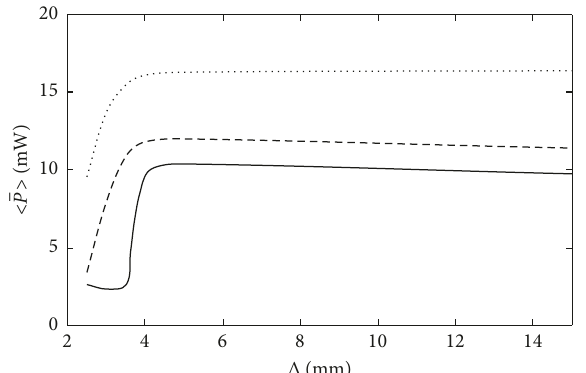
Figure 8: The effective output power generated on the electric load ( R ) as a function of parameter Δ for α � 1 . 0. The solid line is for � 0 . 0, the dashed line is for δ δ 0 � 1 . δ 0